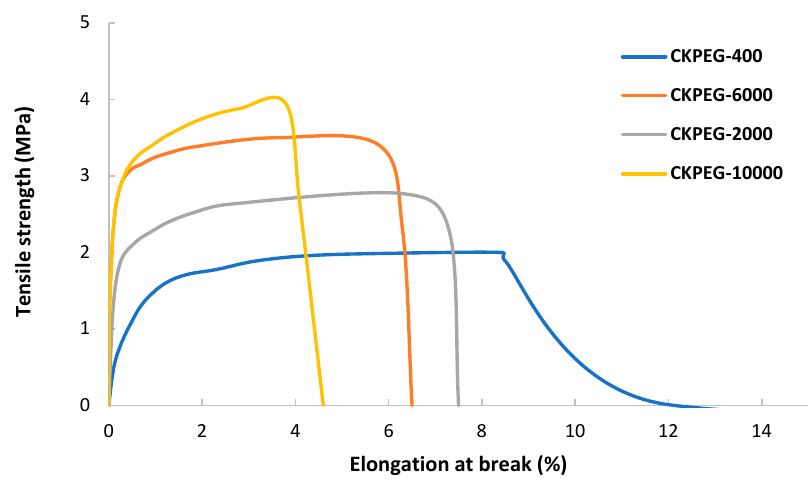
Figure 9. Mechanical properties of composite membranes with varying PEG Mw. Table 3. Mechanical properties of the obtained composite membranes.